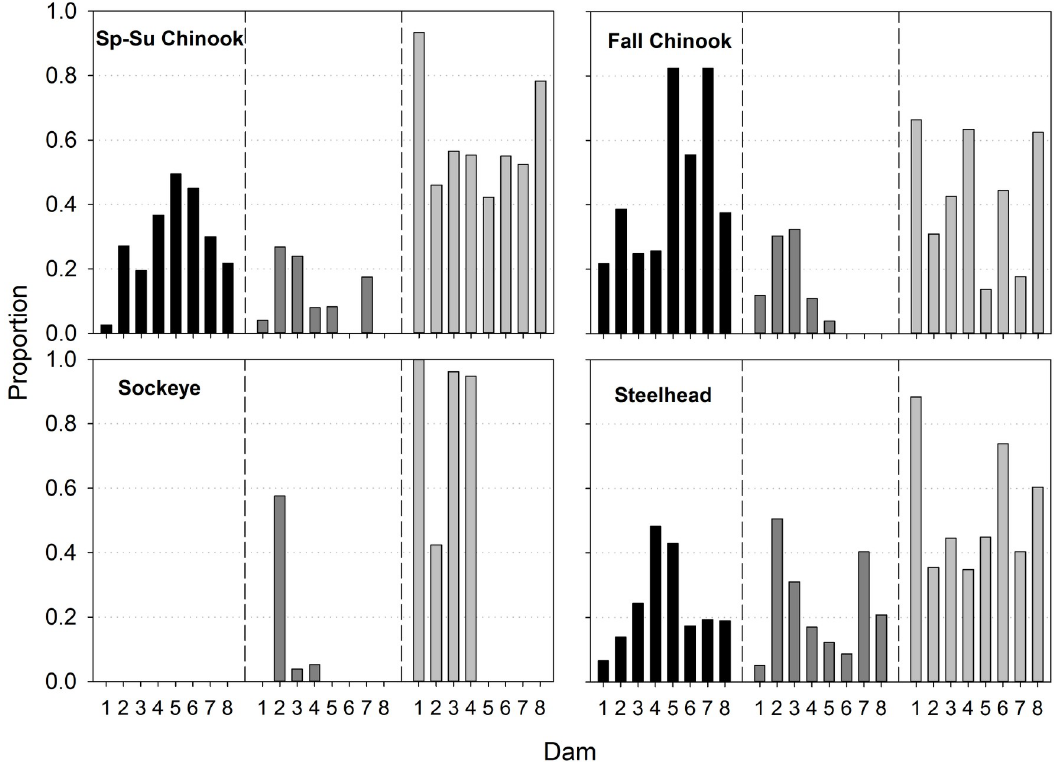
Fig 5. Last detection locations and estimated fate of radio-tagged salmon and steelhead that were detected at dams, but did not pass, shown as the proportion of those that did not pass at each dam. Black bars are the proportion last detected at downstream tributaries, hatcheries, or main stem spawning areas. Dark gray bars are the proportion reported harvested in downstream main stem fisheries. Gray bars are the proportion with unknown downstream fate in the main stem Columbia or Snake rivers. Dams are ordered 1–8 from downstream to upstream: Bonneville, The Dalles, John Day, McNary, Ice Harbor, Lower Monumental, Little Goose, and Lower